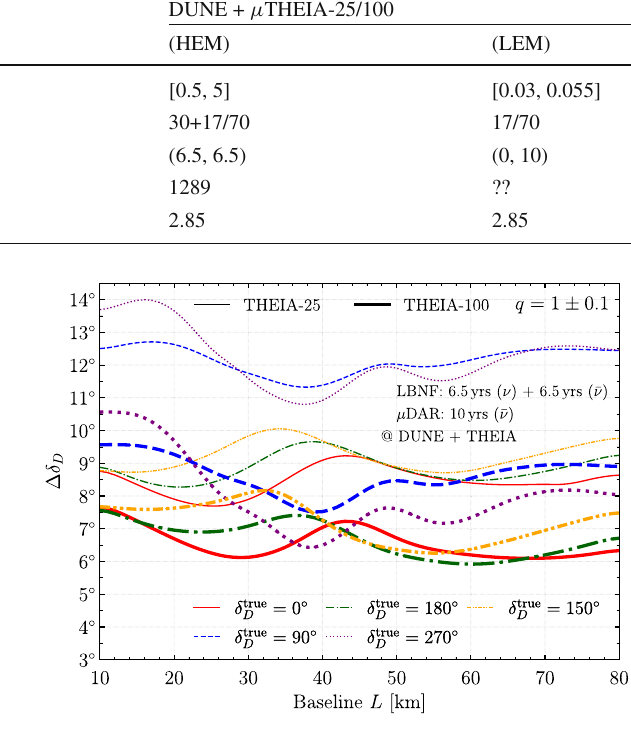
mode. The larger DUNE + μ THEIA-100 (thick lines) has much smaller CP uncertainty than DUNE + μ THEIA-25 (thin lines). To illustrate the matter effect on the CP uncertainty, simulations with fixed q = 1 and a 10% prior on q are shown in the left and right panels,